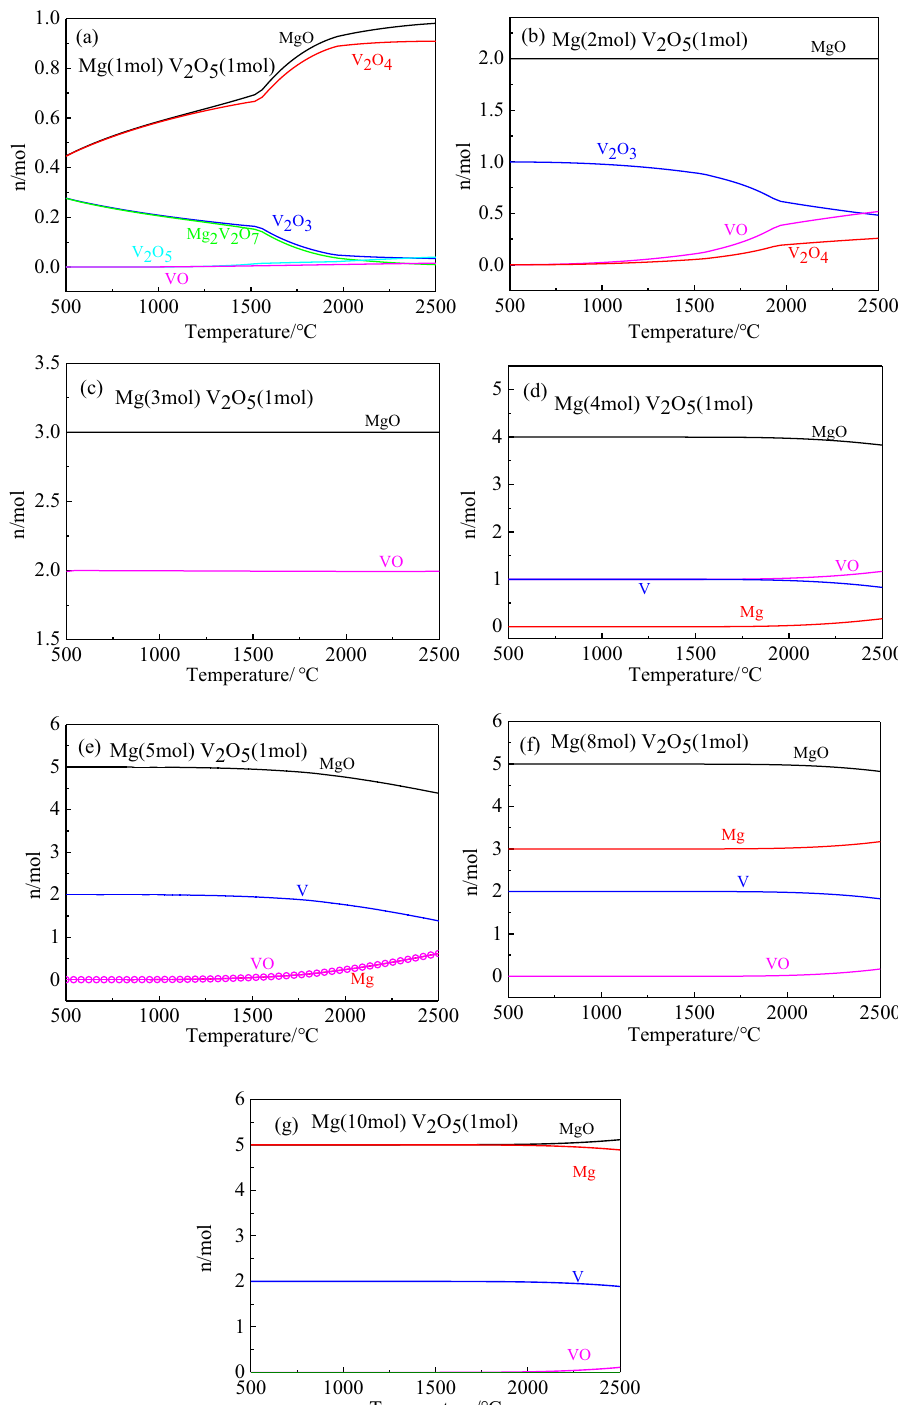
Figure 2: Evolution of equilibrium phases in di ff erent systems: ( a ) Mg:V 2 O 5 = 1:1; ( b ) Mg:V 2 O 5 = 2:1; ( c ) Mg:V 2 O 5 = 3:1; ( d ) Mg:V 2 O 5 = 4:1; ( e ) Mg:V = 5:1; ( f ) Mg:V = 8:1; and ( g ) Mg:V = 2 O 5 2 O 5 2 O 5